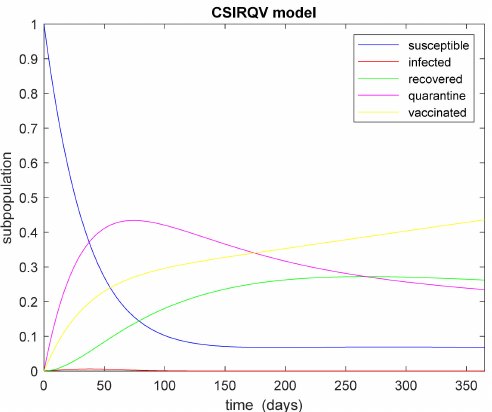
Figure 14. Dynamics of the CSIRVQ model ( α = 0.18, β = 0.06, γ = 0.006, δ = 0.001, ε = 0.008333, ζ = 0.06, η = 0.0001, θ = 0.0006, ι = 0.006, κ = 0.00008333, λ = 0.00001, µ = 0.0001). Cumulative Viral load: 0.23 (t = 365